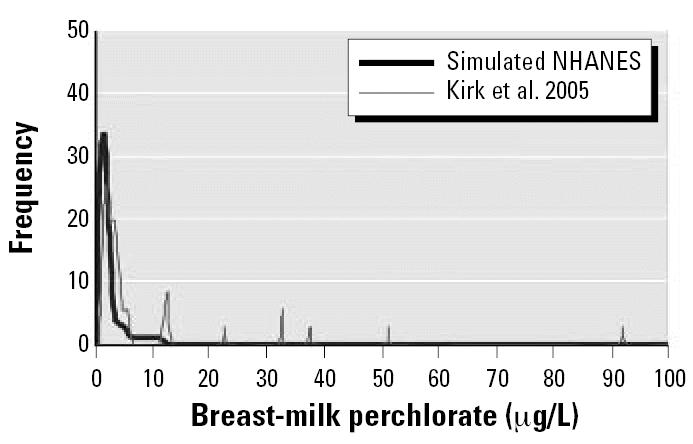
Breast-milk perchlorate simulated from NHANES data versus actual data. Reported by Kirk et al. (2005).